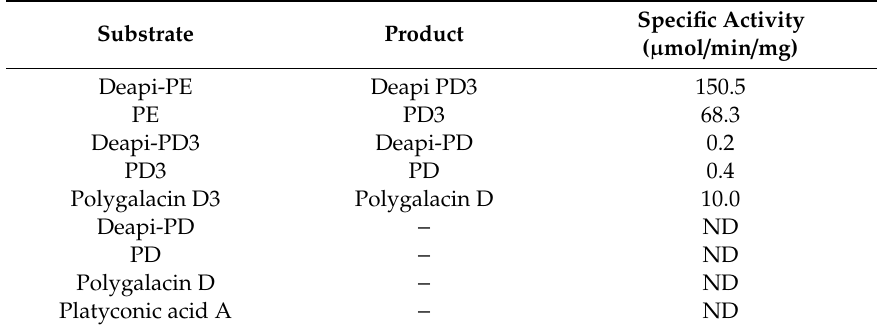
Table 1. Substrate specificity of the β -glucosidase from Caldicellulosiruptor bescii for